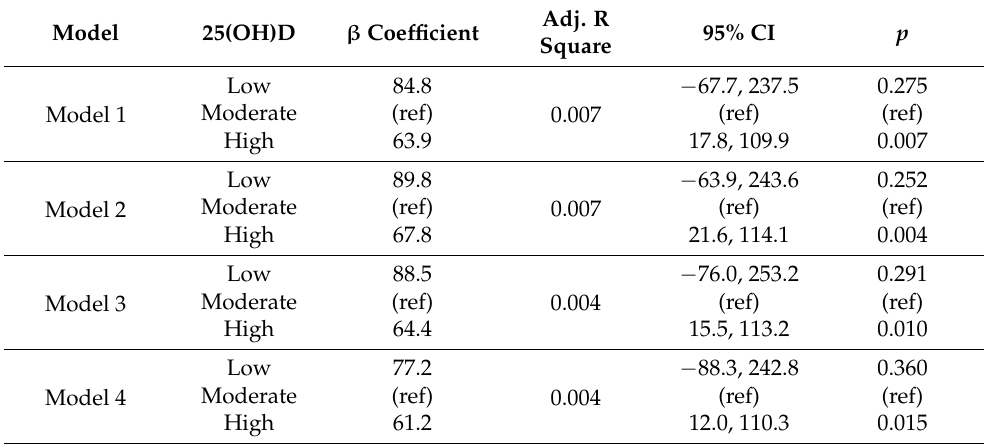
Figure 2. The association between 25(OH)D concentration and telomere length at baseline in the Newcastle 85+ Study. Table 2. Association between 25(OH)D cut-offs and telomere length at baseline.